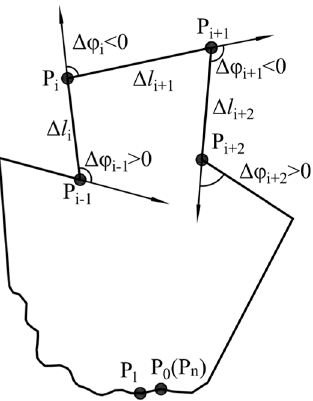
Figure 2. Description of Particle shape using the result of the Z-R shape function.